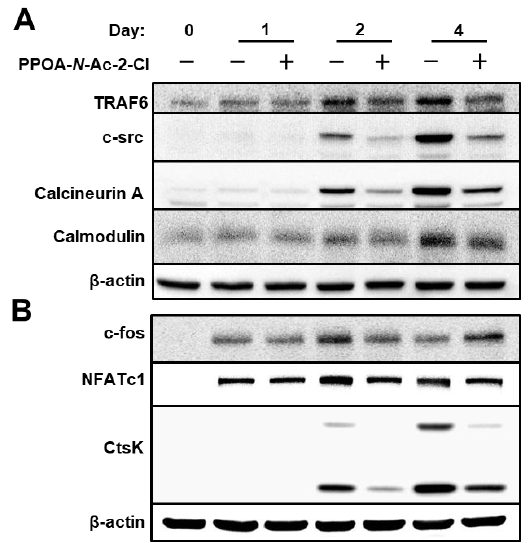
Figure 7. PPOA- N -Ac-2-Cl suppresses the expression of TRAF6. ( A , B ) BMMs were cultured with 6 µ M PPOA- N -Ac-2-Cl for 0, 1, 2, or 4 days in the induction medium. Cell lysates were prepared and immunoblotting was performed with the indicated antibodies. The densitometry graphs for the blots are shown in Figure S4.